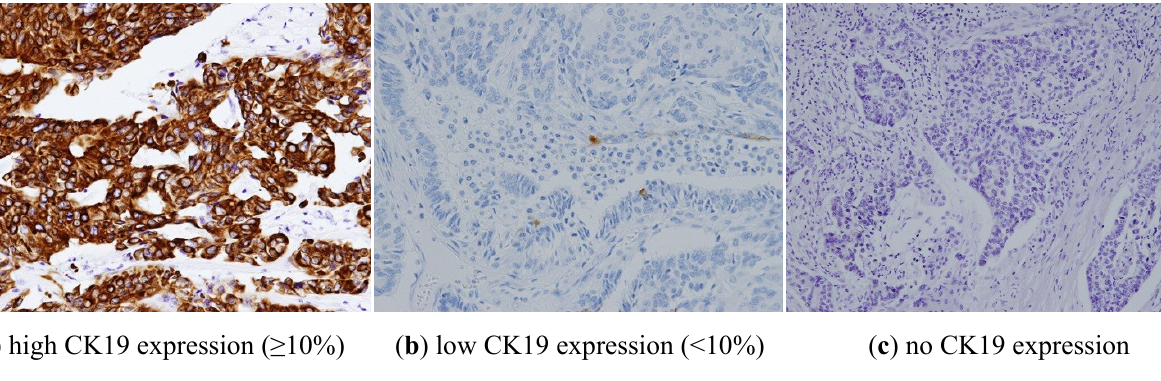
Figure 1. Staining characteristics of CK19 using